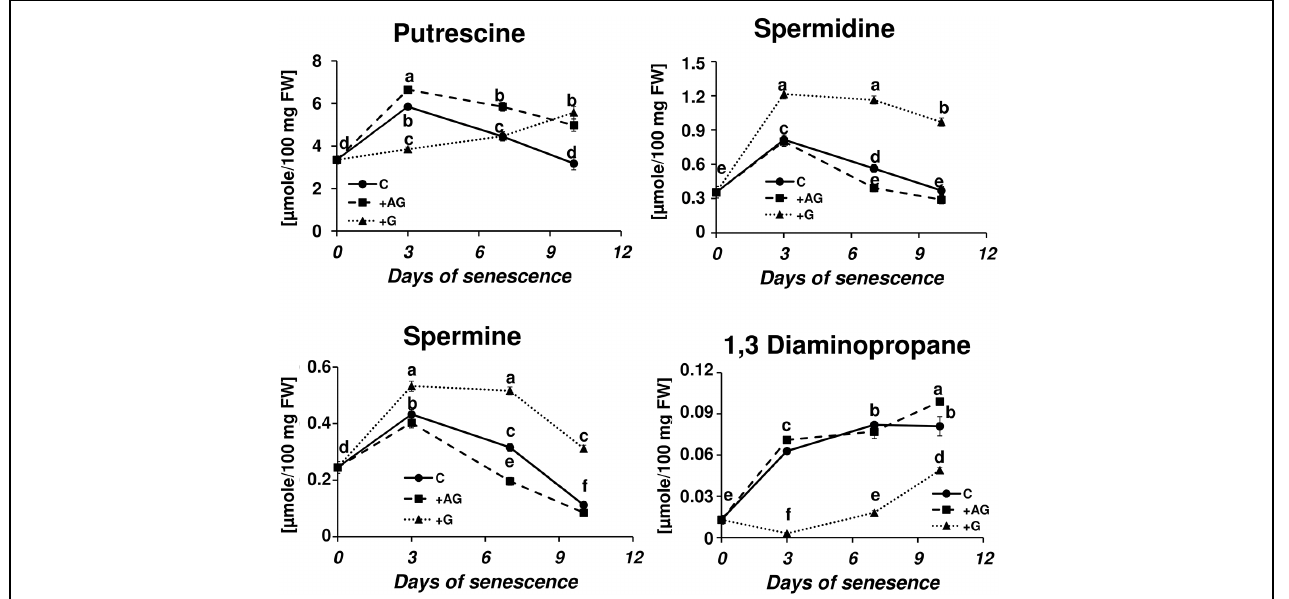
FIGURE 5 | Senescence-related changes in free polyamine level in dark-incubated conditions in the presence of PA catabolism inhibitors in barley leaves. Polyamines (PAs) were estimated in C (solid line)- control leaves and after application of polyamine catabolism inhibitors: + AG (dashed line) – leaves treated with 10 μ M N,N -diaminoguanidine (AG) – diamine oxidase (DAO) inhibitor; + G (dotted line) leaves treated with 50 μ M guazatine (G) – polyamine oxidase (PAO) inhibitor. Putrescine, spermidine, spermine, and diaminopropane concentrations were determined using HPLC after polyamine derivatization with dansyl chloride. The values are reported in micromoles relative to leaf FW. The differences in the measured parameters were analyzed for statistical significance using one-way ANOVA and the Tukey–Kramer Multiple Comparison Test ( n = 12, p < 0.01). The same letters on bars describe non-significant differences between means.